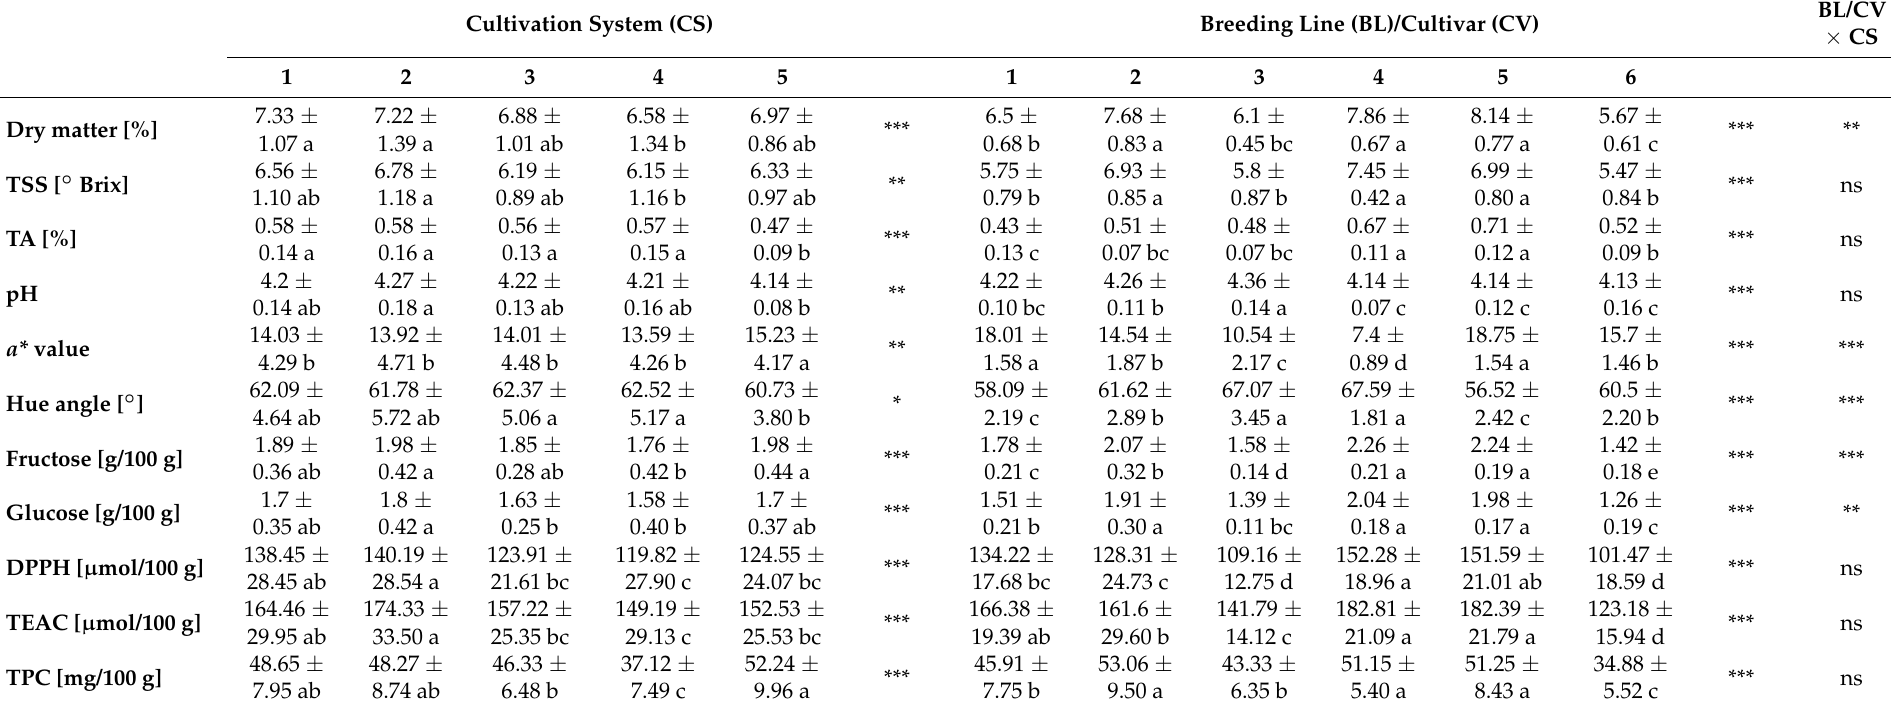
Table 3. Mean values ± standard deviation of quality parameters, fructose and glucose content, antioxidant capacity, and total phenolic content in five cultivation systems of five breeding lines and Lyterno F 1 , calculated on fresh matter